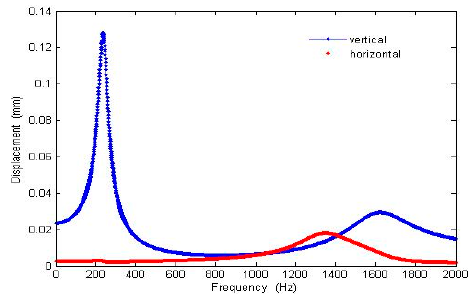
Figure 8. ANSYS Workbench harmonic responses of the optimized design with 60 µ m × 60 µ m × 4 µ m proof mass, 1820 µ m waveguide length and 20 µ m slab width.